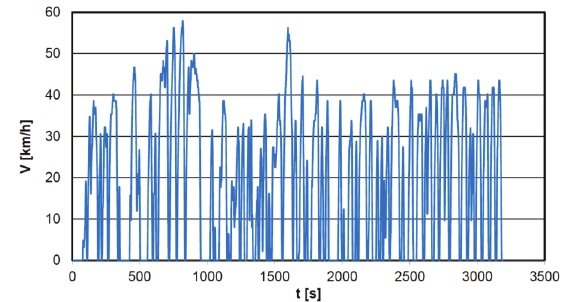
Fig. 24. Vehicle speed characteristic on the city buses test route